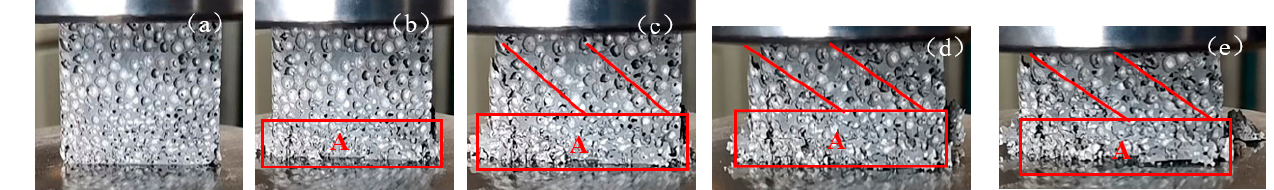
Figure 7. A macroscopic diagram of the deformation process of two-layered gradient Al foams with a cell size of 3-2. Deformation strain: ( a ) ε = 0.01, ( b ) ε = 0.08, ( c ) ε = 0.21, ( d ) ε = 0.38, ( e ) ε = 0.46; A indicates the obvious collapse area.